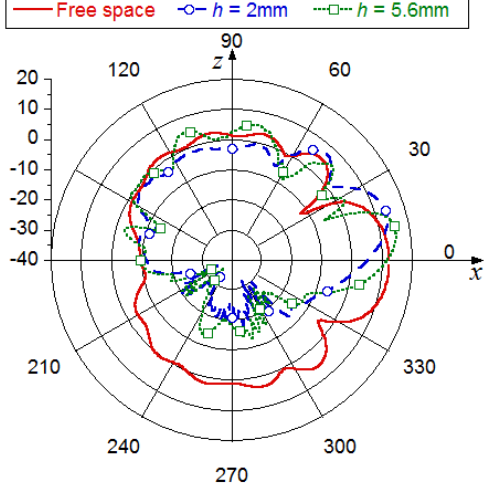
Figure 7. Simulated gain ( H -plane) for different antenna/phantom